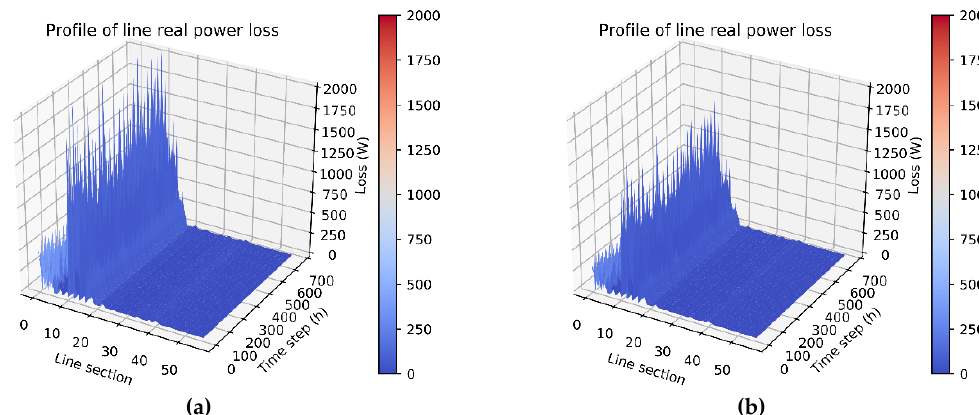
Figure 17. Energy loss profiles: ( a ) before rephasing and ( b ) after rephasing.